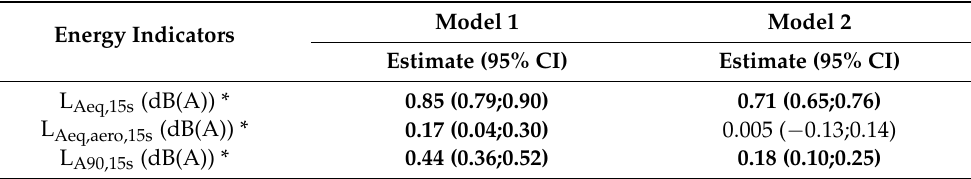
Table 3. Association between energy indicators estimated every 15 s and heart rate measured every 15 s during the sleep period